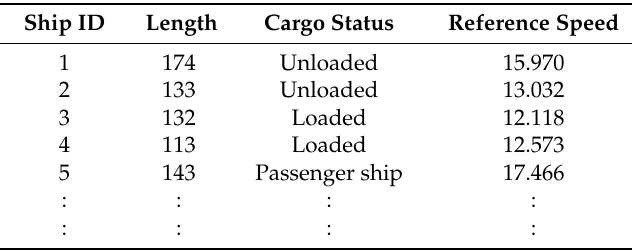
Table 1. Example of reference ship